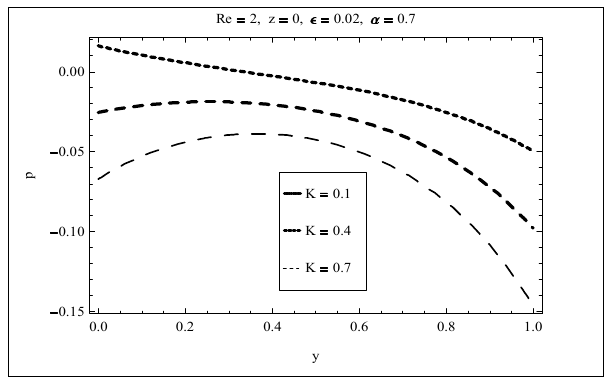
Figure 16. Effect of K on pressure p along y .